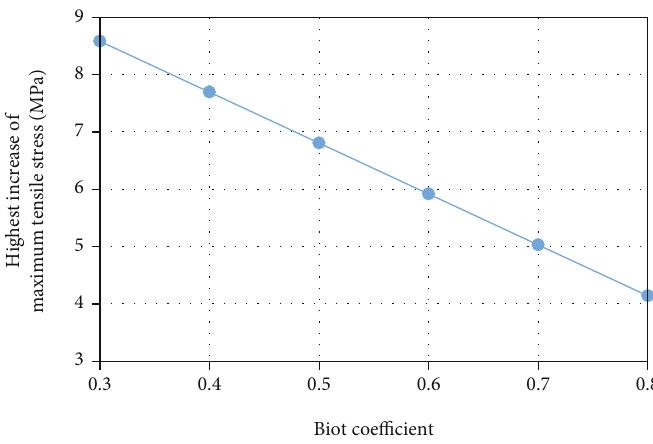
Figure 17: Highest increment of maximum tensile stress with di ff erent Biot coe ffi cient.